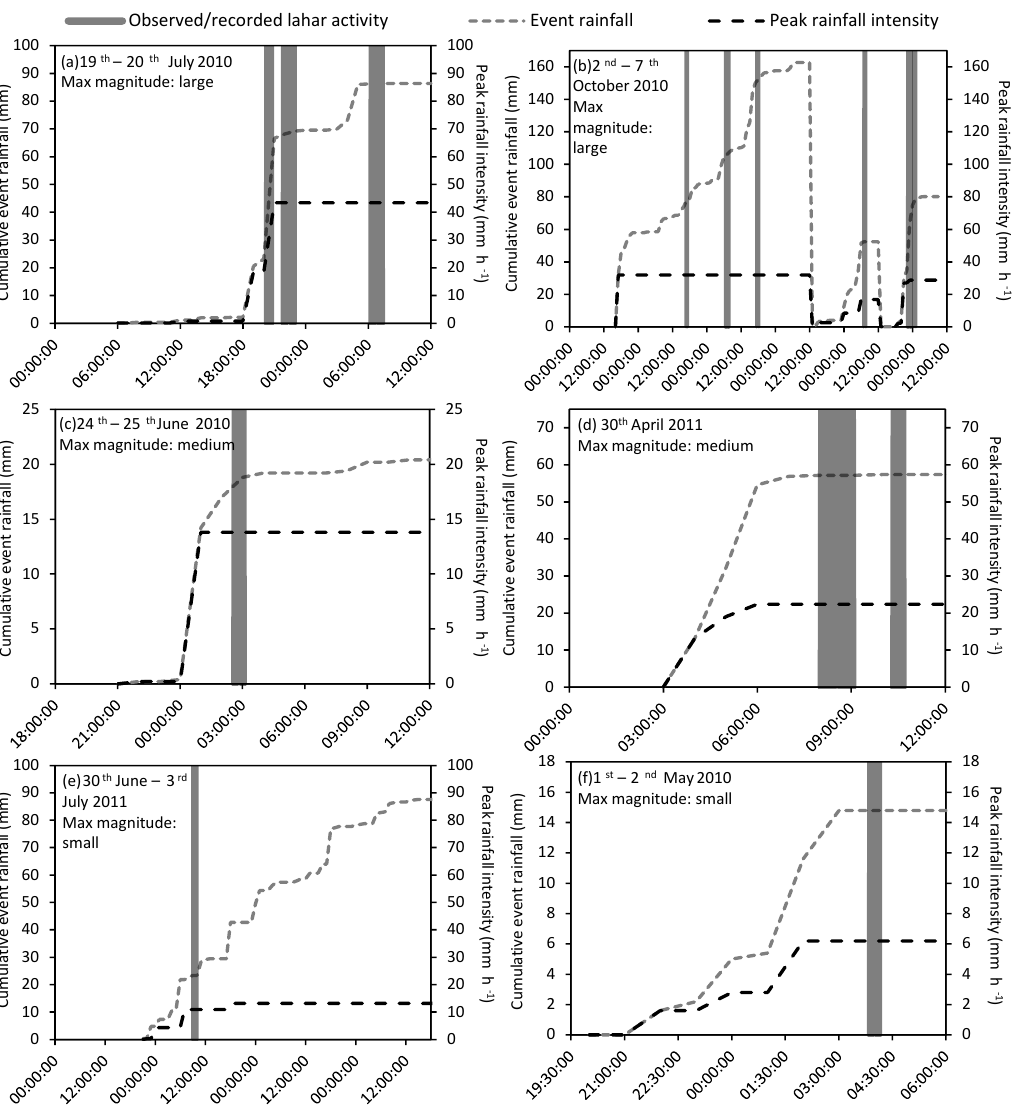
Figure 3. Timelines displaying examples of lahar-triggering rainfall in the Belham valley, Montserrat, between April 2010 and April 2012. Alongside the timing of lahar observation and/or detection, the cumulative recorded rainfall (mm) and 1h peak rainfall intensity (1hPRI – mmh − 1 ) of the rainfall events are